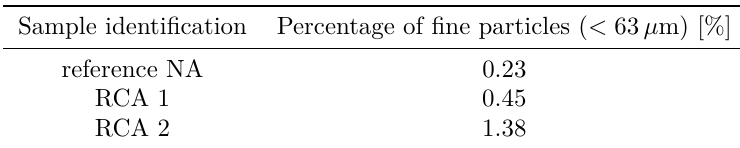
Table 1. Determination of percentage of fine particles.